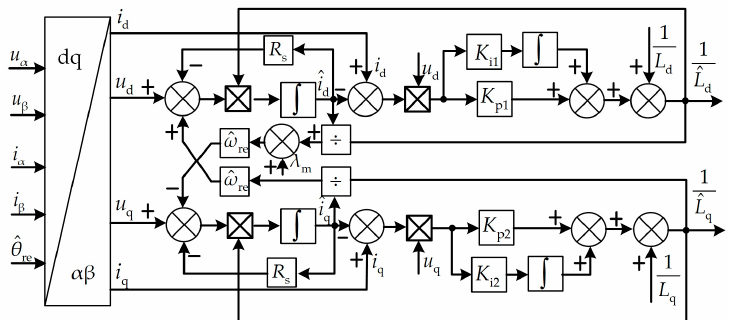
Figure 4. Block diagram of inductance parameters identification on line based on model reference adaptive observer (MRAS).